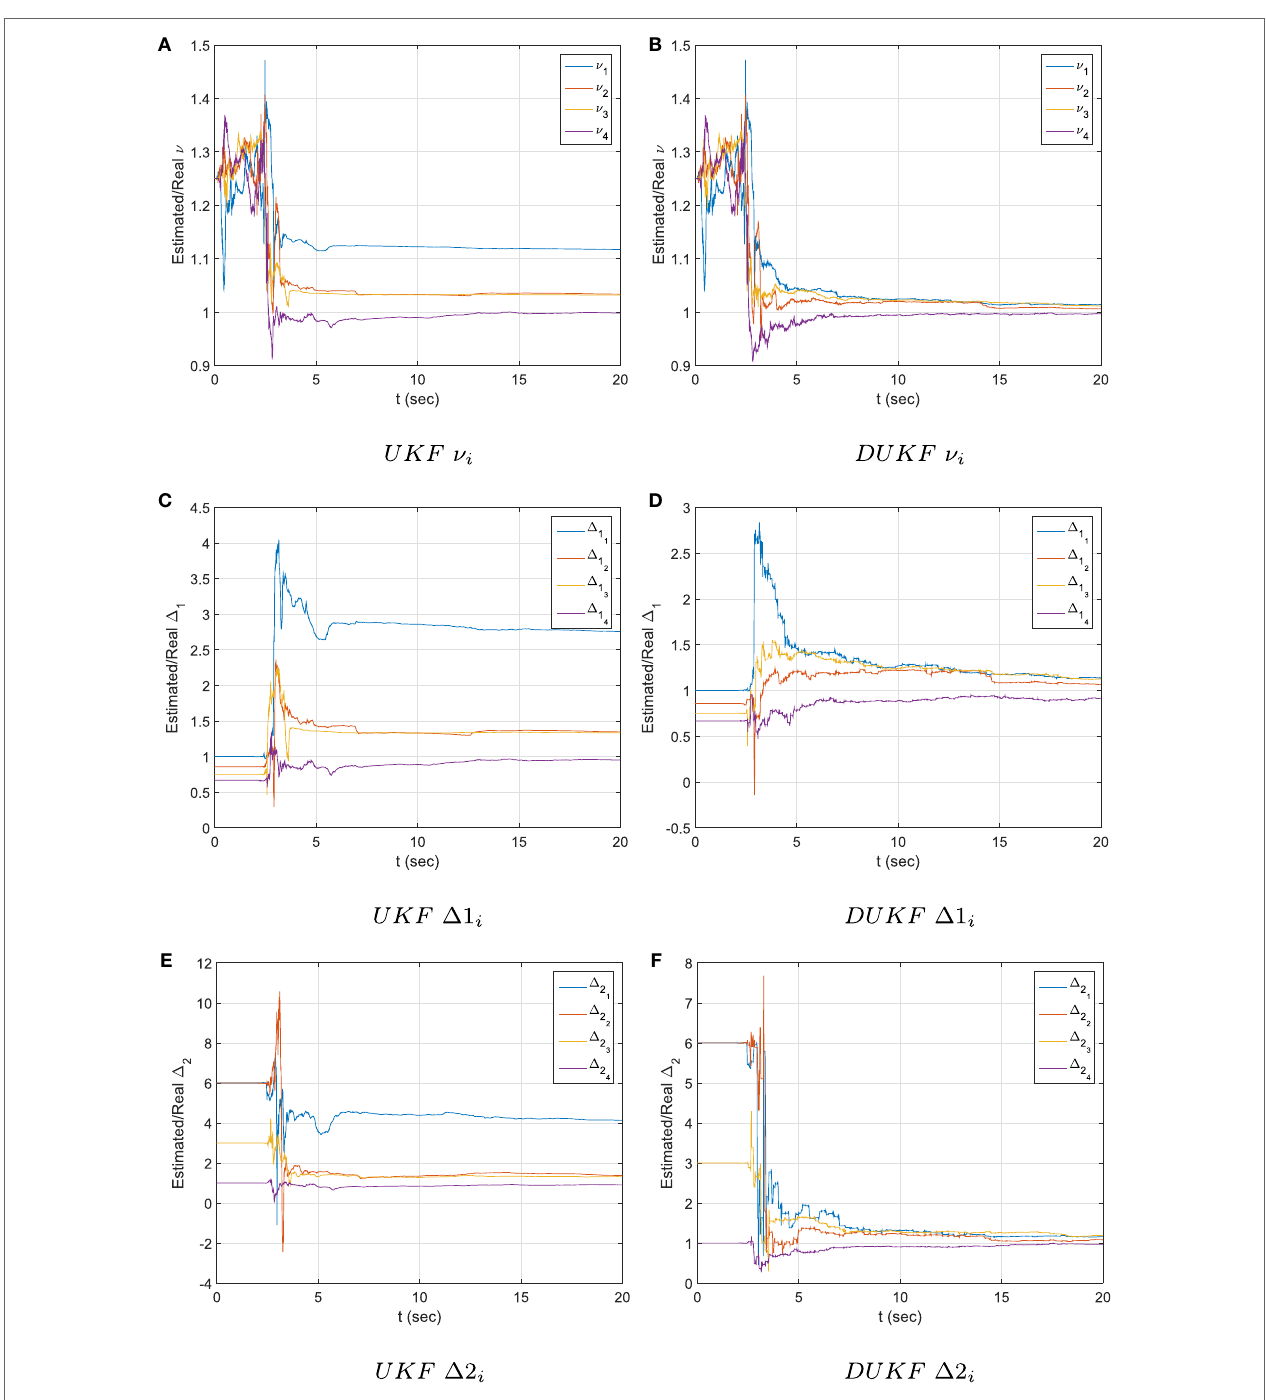
FIGURE 9 | Bouc–Wen parameters identified by the UKF and